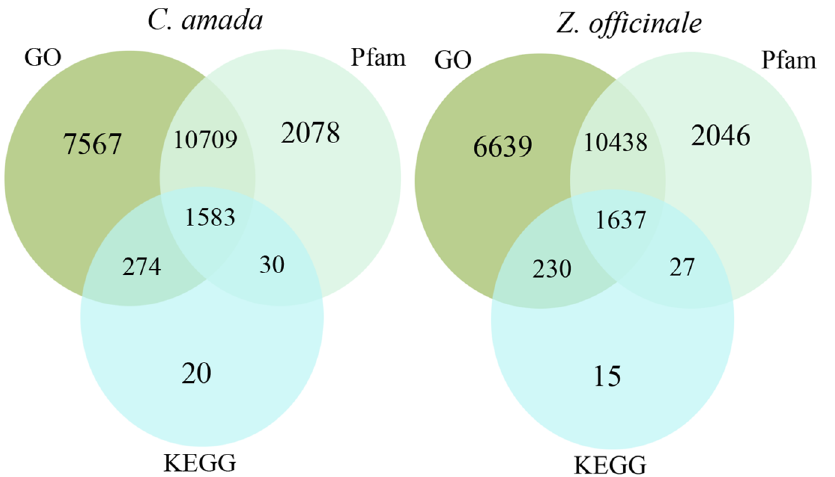
Figure 2. Distribution of similarity search results showed by Venn diagrams. The number of unique sequence-based annotations is the sum of unique best BLASTX hits from the GO term, Pfam domains and KEGG databases, respectively. The overlap regions among the three circles contain the number of unigenes that share BLASTX similarity with respective databases.